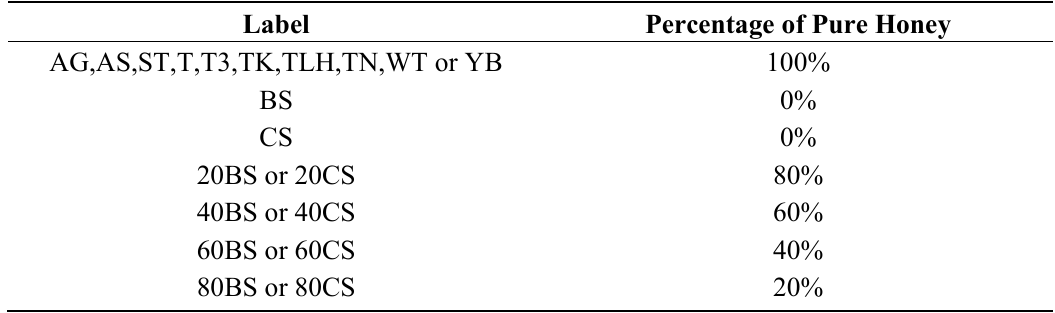
Table 2. Description of mixture for different samples of honey and sugar (BS or CS).